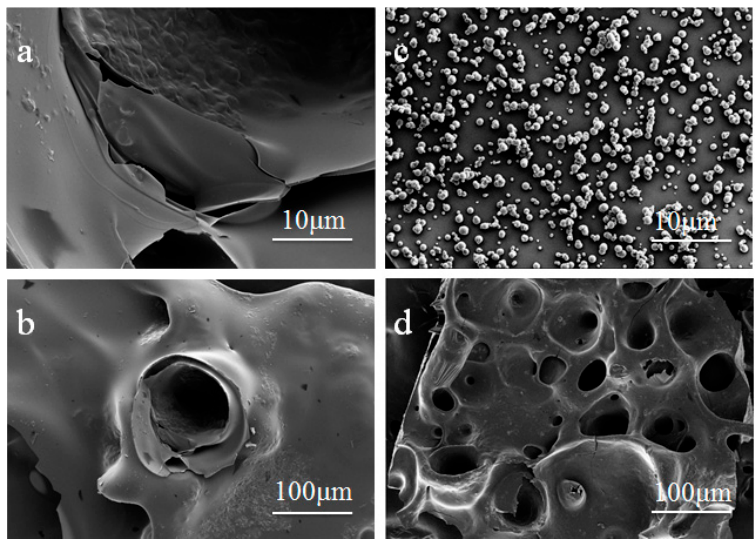
Figure 6. SEM images of the char residue of the PC/HSPCTP composites: outer surface of pure PC ( a ), PC/HSPCTP3 ( c ); inner surface of pure PC ( b ), PC/HSPCTP3 ( d ).